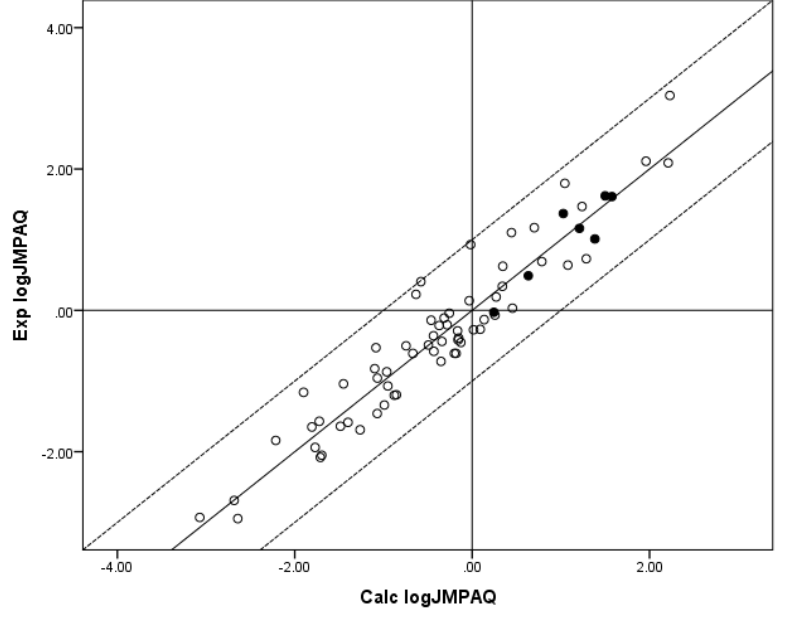
Figure 1. The correlation of the calculated (Calc.) log J from the fit of n = 70 to RS MPAQ with the experimental (Exp.) log J . The dashed lines represent the boundaries for residual MPAQ log J greater than 1.0, the solid line indicates points where the Calc. log J is MPAQ MPAQ equivalent to the Exp. log J . The filled circles indicate the n = 7 phenols. The Calc. MPAQ log J values were determined with Equation 5: log J = −1.606 + 0.695 log S + MPAQ MPAQ OCT 0.305 log S − 0.00490MW. r 2 = 0.907, average absolute residual log J = AQ MPAQ